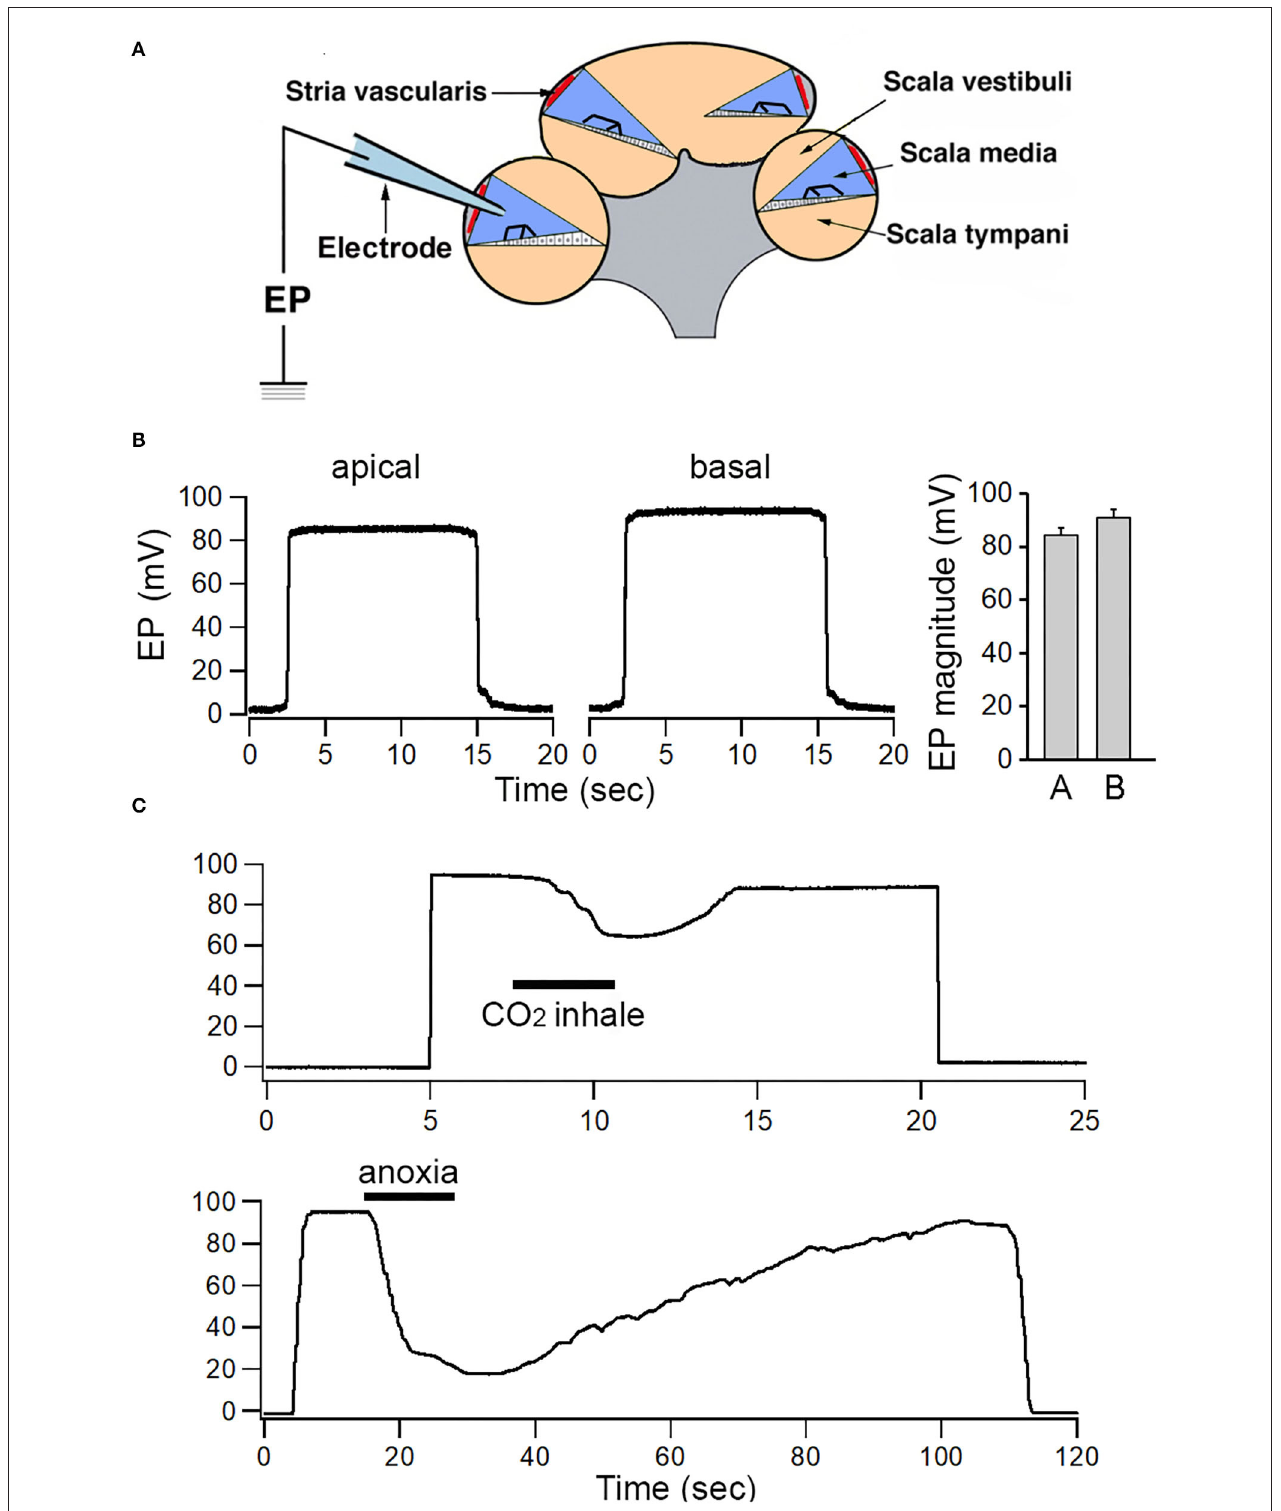
FIGURE 1 | Recording of EP from apical and basal turns of the cochlea. (A) Schematic view of electrode path for recording EP through lateral wall approach. (B) Examples of EP recorded from apical and basal turns. Mean and SD of EP recorded from eight apical and eight basal turn locations are shown in the right panel. (C) Change in EP magnitude in response to temporal CO 2 inhalation and anoxia.